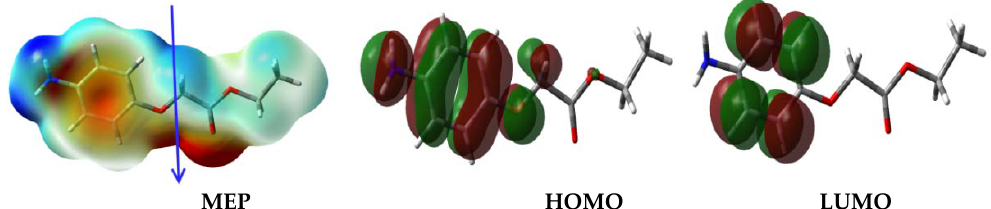
Figure 10. The MEP, HOMO, and LUMO of 4 .